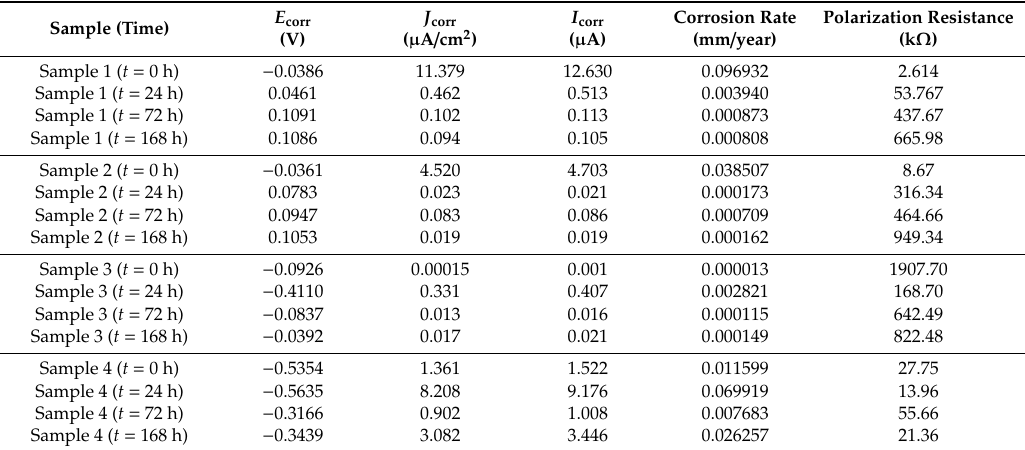
Figure 8. Corrosion rate curves for Samples 1–4 throughout 168 h of immersion. Table 1. Tafel parameter values—corrosion potential, current density, current intensity, and polarization resistance for Samples 1–4 over 168